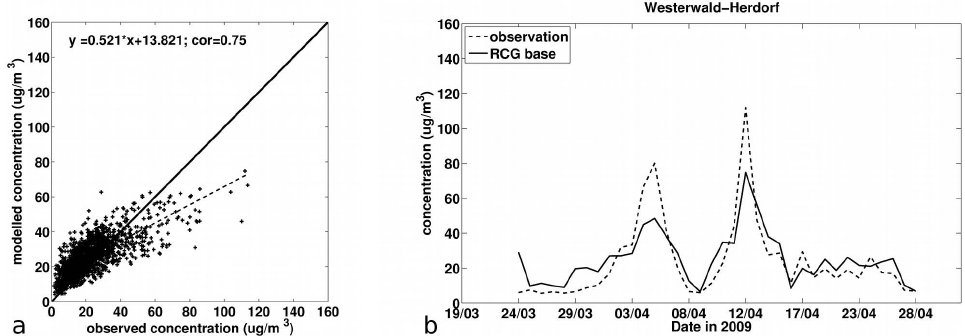
Fig. 5. Daily mean modelled PM 10 concentrations (a) versus observations at 42 AirBase sites and (b) versus observations at AirBase site Westerwald-Herdorf.